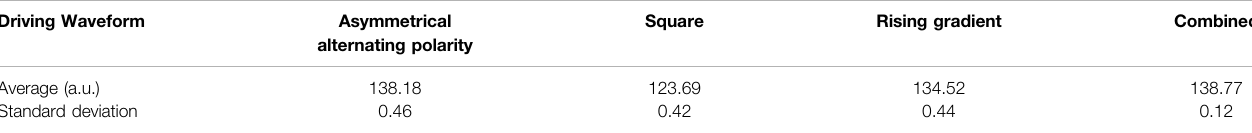
TABLE 5 | Driving effect comparison by four different driving waveforms used to drive EWDs. Driving Waveform Asymmetrical Square Rising gradient Combined alternating polarity Average